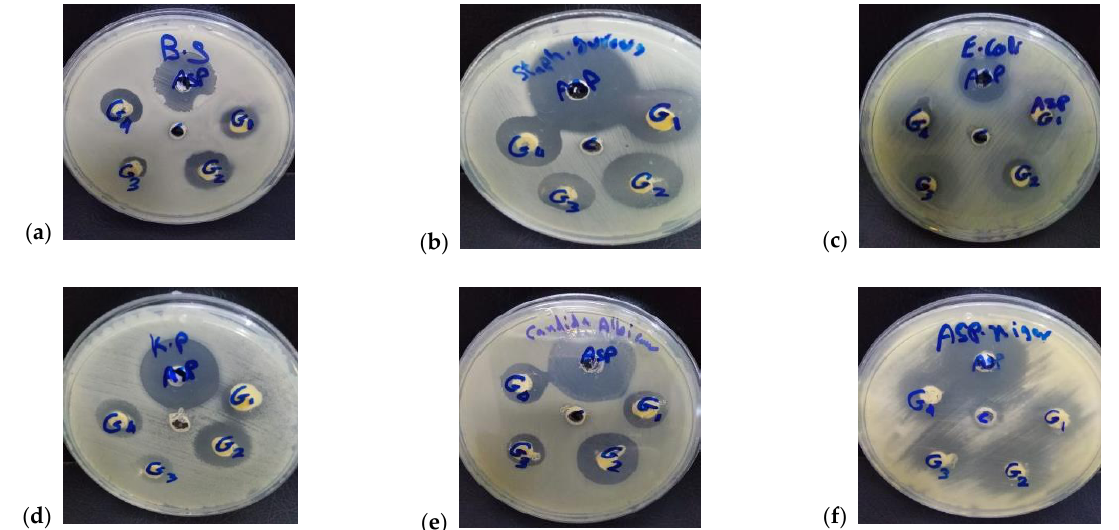
Figure 7. Images of Petri dishes with the inhibition zones against gram-positive bacteria, ( a ) B. subtilis ; ( b ) S. aureus ; two Gram-negative bacteria, ( c ) E. coli; and ( d ) K. pneumoniae , and two yeast, ( e ) C. albicans, and ( f ) A. niger , of aspirin and its derivatives G1-D3-Asp , G2-D6-Asp , G3-D9-Asp , and G4-D12-Asp .